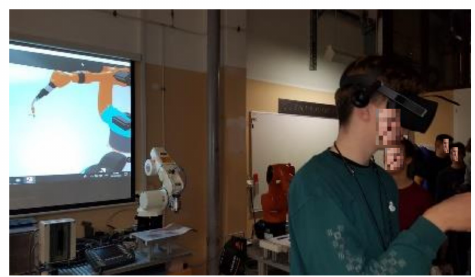
Figure 4. Cyber VR training.